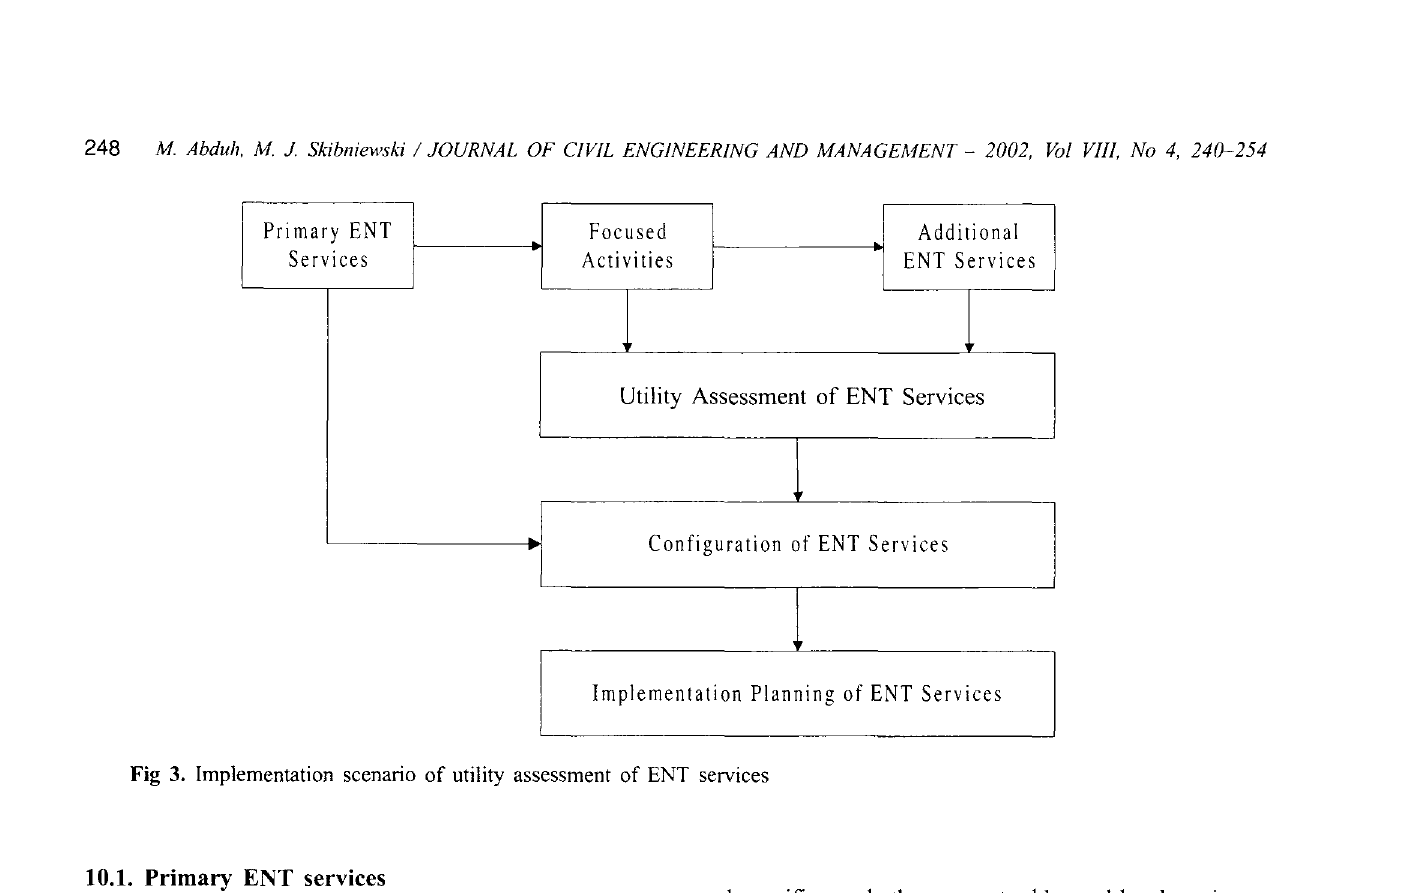
Fig 3. Implementation scenario of utility assessment of ENT services